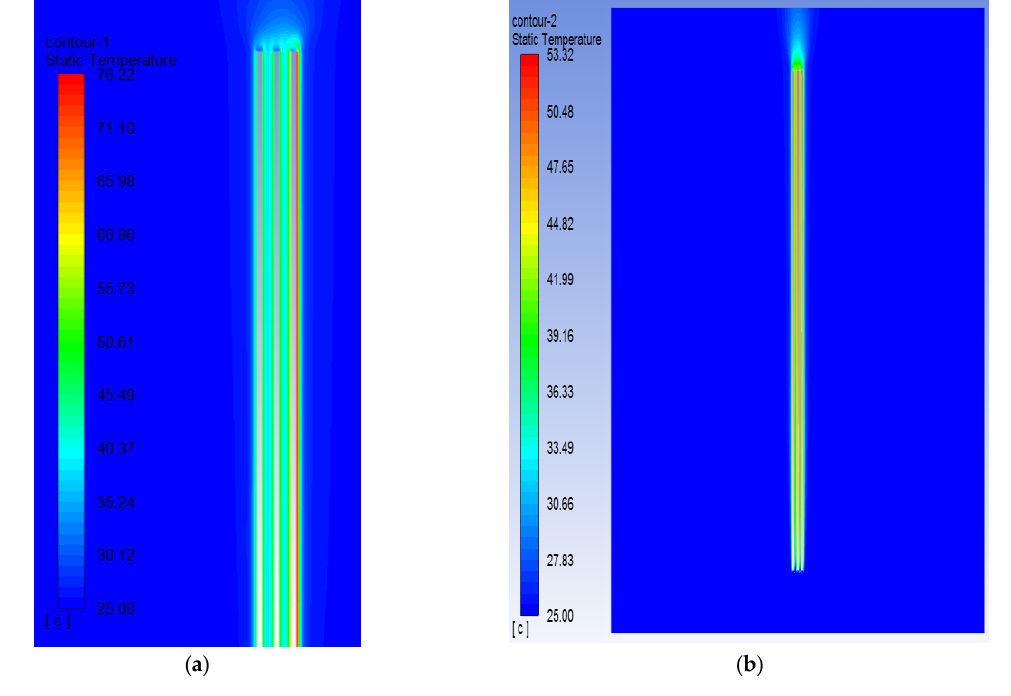
Figure 10. Temperature distribution around power cables (load equal to 117.5 A as permissible in the ground of the soil resistivity 2.5 (K·m)/W): ( a ) with solar radiation (max insulation temp. 76.22 °C); ( b ) without solar radiation (max insulation temp. 53.32 °C).